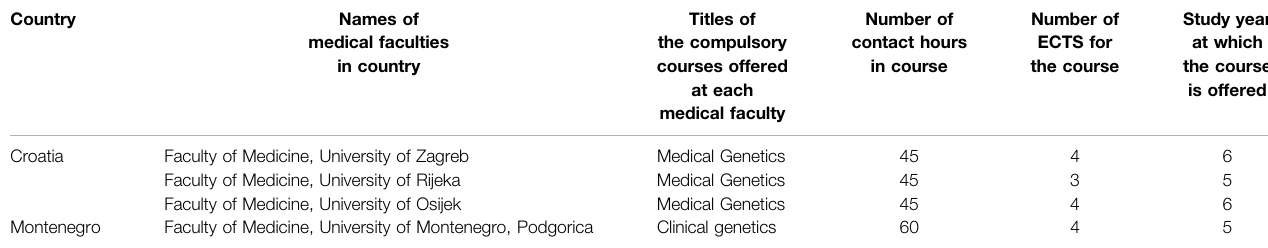
TABLE 2 | Clinical courses in medical genetics offered at medical faculties for medical students in Balkan countries with Slavic languages.